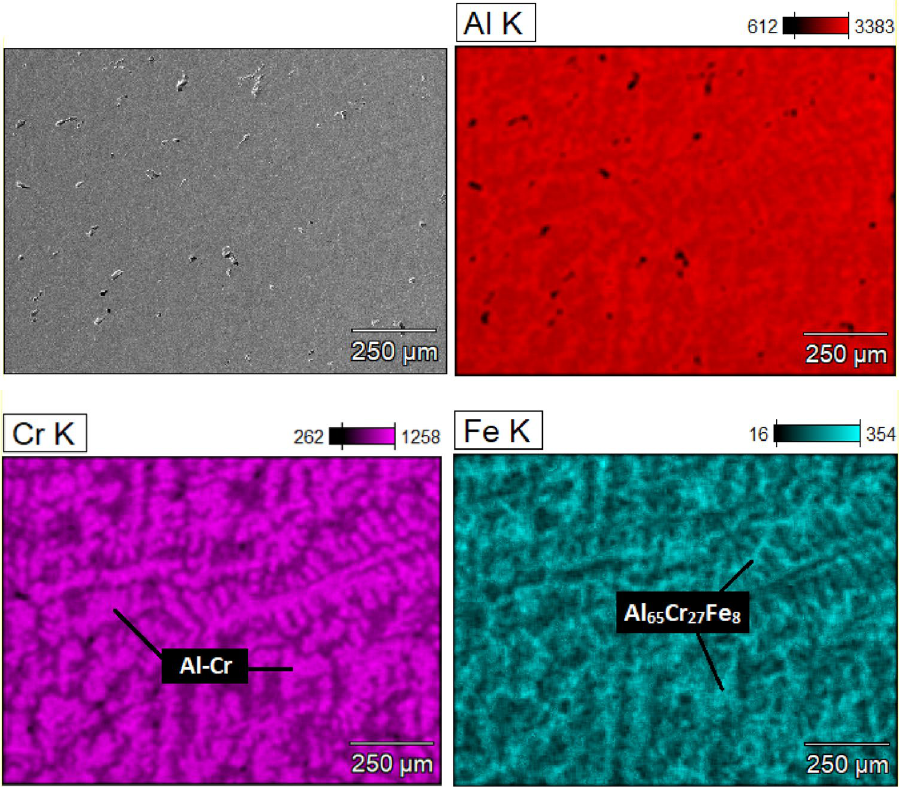
Figure 3. EDX maps of Al 71 Cr 24 Fe 5 alloy in a form of